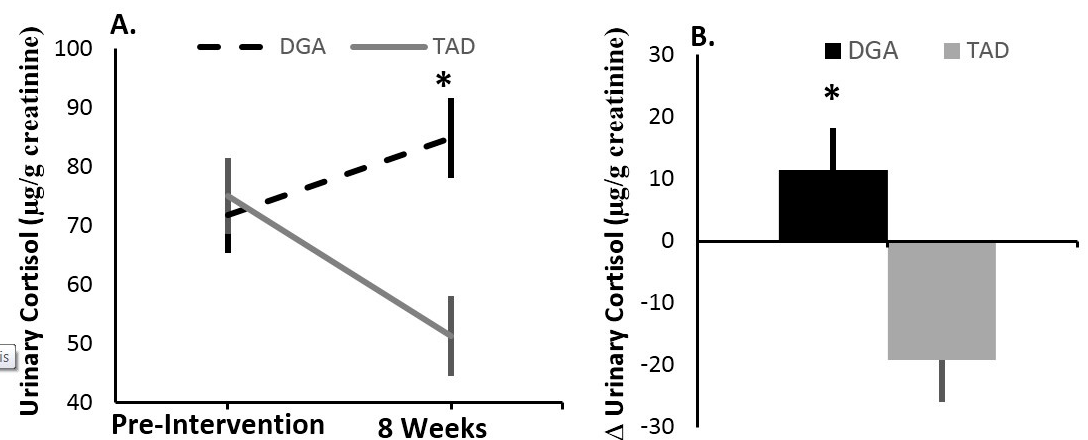
Figure 3. After controlling for the pre-intervention to intervention dietary shift in HEI for sodium, urinary cortisol concentration increased in the DGA group, while this stress marker declined in the TAD group. ( A ) shows pre-intervention and 8 week values (lsmean ± s.e.); ( B ) displays the delta (lsmean ± s.e.) between 8 week and pre-intervention values. All statistical models included diet group (DGA vs. TAD) and the covariates age, education, BMI, baseline stress marker, and the pre-intervention to intervention dietary change in HEI for sodium. * Indicates a significant ( p < 0.02) difference between the DGA and TAD groups. DGA, Dietary Guidelines for Americans intervention group. TAD, Typical American Diet intervention group.